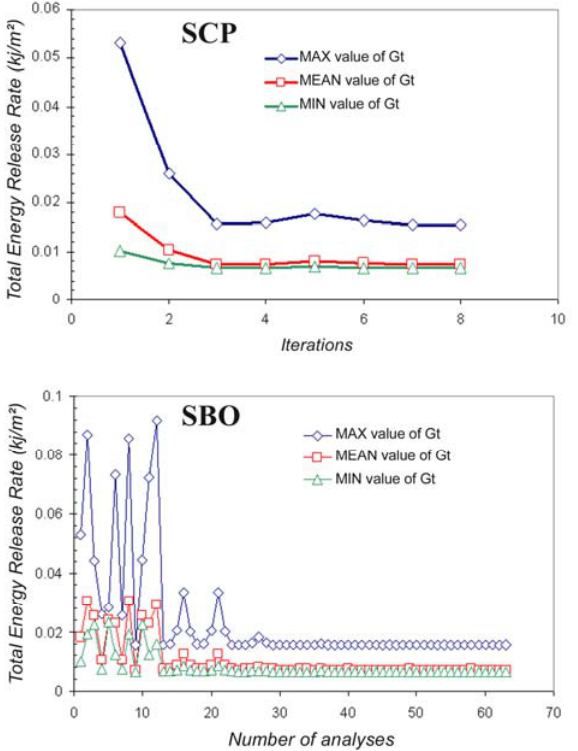
Fig. 7. The ENF test case, on its finite element model